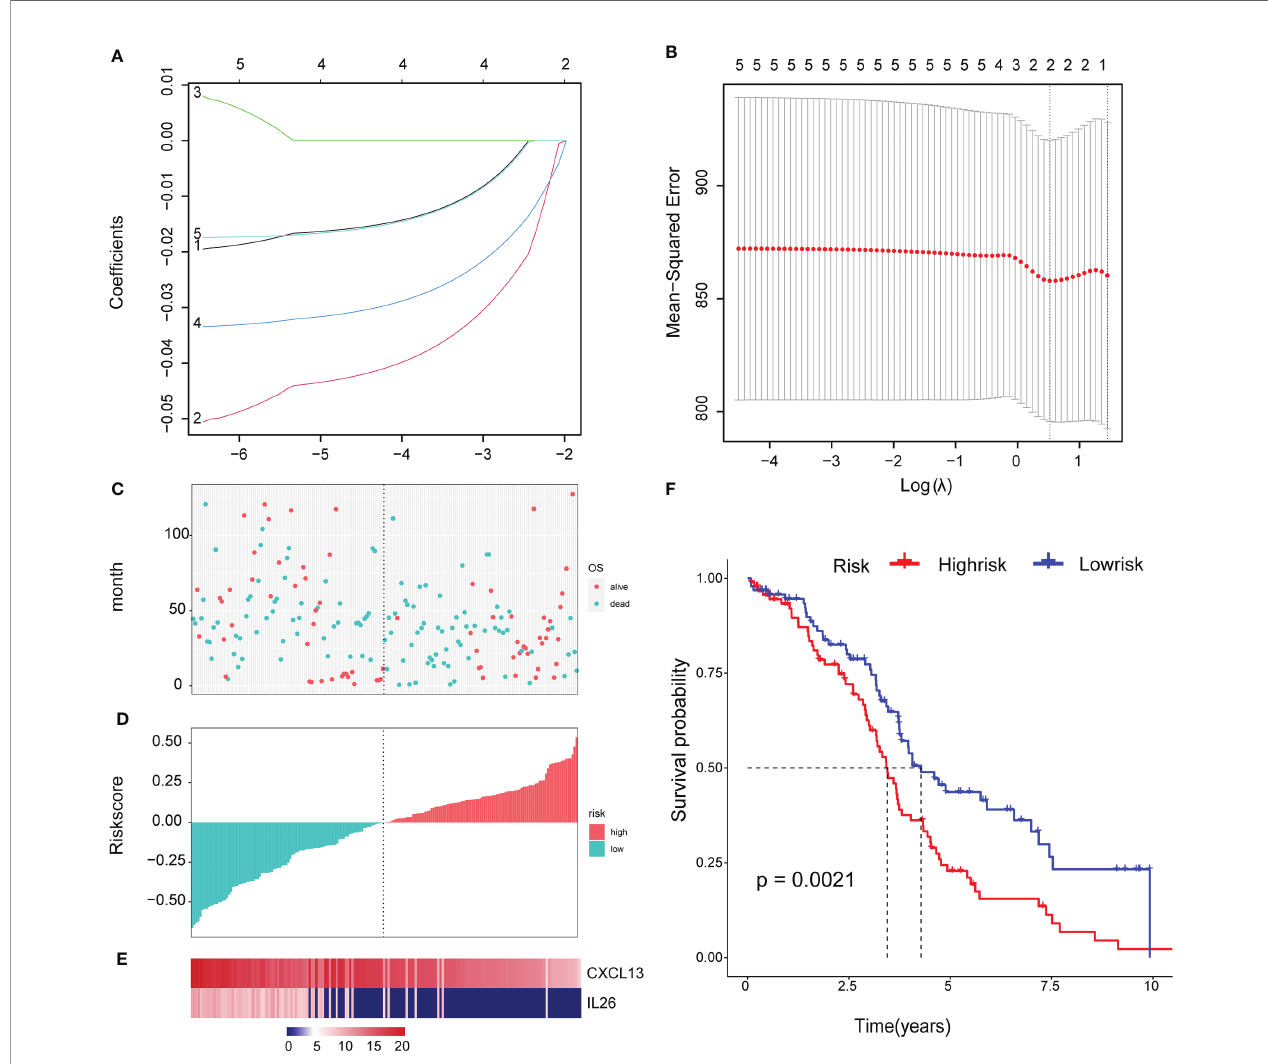
FIGURE 7 | Construct a genetic risk model: (A) The trajectory of each independent variable: the horizontal axis represents the log value of the independent variable lambda, and the vertical axis represents the coef fi cient of the independent variable. (B) The con fi dence interval under each lambda. (C) The horizontal axis is the patient ’ s risk score, ranked from lowest to highest, the vertical axis is survival, the green dots are dead, and the red dots are survival. (D) The abscissa shows the patient ’ s risk score from low to high, the ordinate is the standardized risk score, the red represents the high-risk group, and the green represents the low risk group. (E) 2 Expression of Gene Signature in all TCGA patients. The abscissa shows the order of patients ’ risk score from low to high. (F) Survival curve of high and low risk